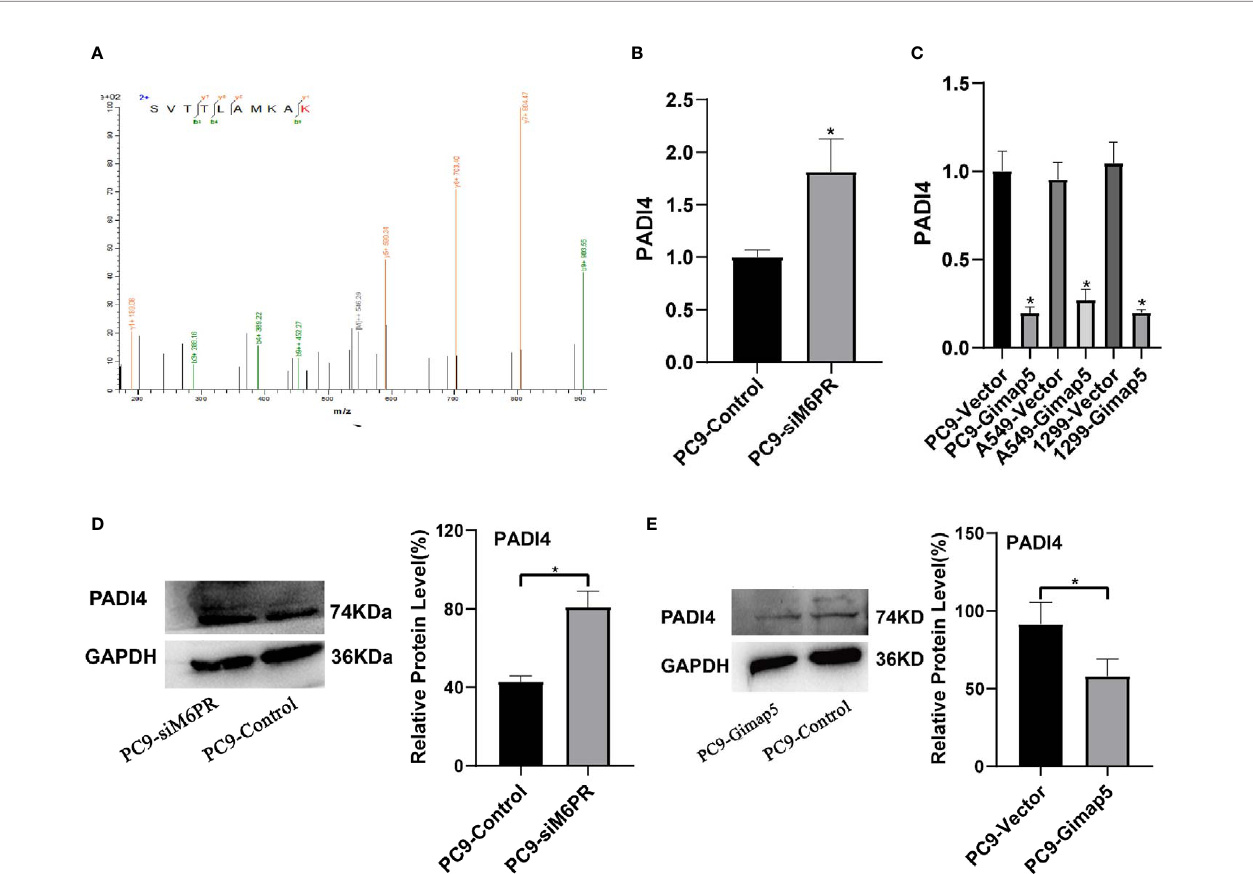
FIGURE 7 | Gimap5 down-regulates the expression of PADI4 (n = 3). (A) Secondary peptide spectra of PADI4 were detected in the Co-IP products using M6PR antibody. (B, D) the mRNA and protein expression levels of PADI4 after siM6PR transfection was assayed using qRT-PCR and western blot. (C, E) the mRNA and protein expression levels of PADI4 after Gimap5 overexpression was detected using qRT-PCR and western blot. All the data were expressed as mean ± SEM of the three independent experiments (* p < 0.05 vs. empty